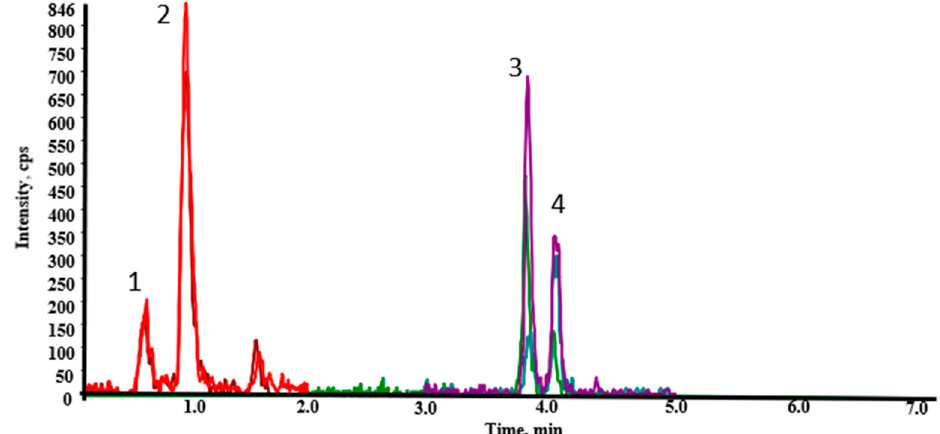
Figure 2. UHPLC-ESI (+)-MS/MS extracted ion chromatogram of naturally contaminated sample of oat bran with four EAs: (1) Em, (2) Emn, (3) Esn, (4) Es.